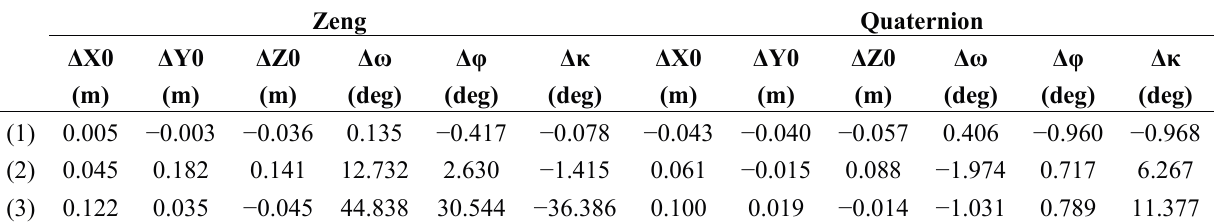
Table 1. Results from images taken on the calibration test field: differences between the external parameters evaluated by a bundle adjustment software and with both Zeng and quaternion approaches applied to the three images in Figure 2. The first column refers to the image number. Zeng Quaternion